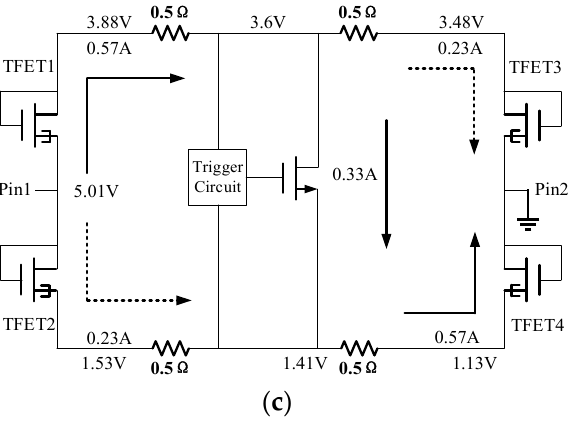
Figure 8. Transmission line pulse response of ( a ) point TFET-, ( b ) line TFET- and ( c ) Ge-source TFET-based ESD networks.